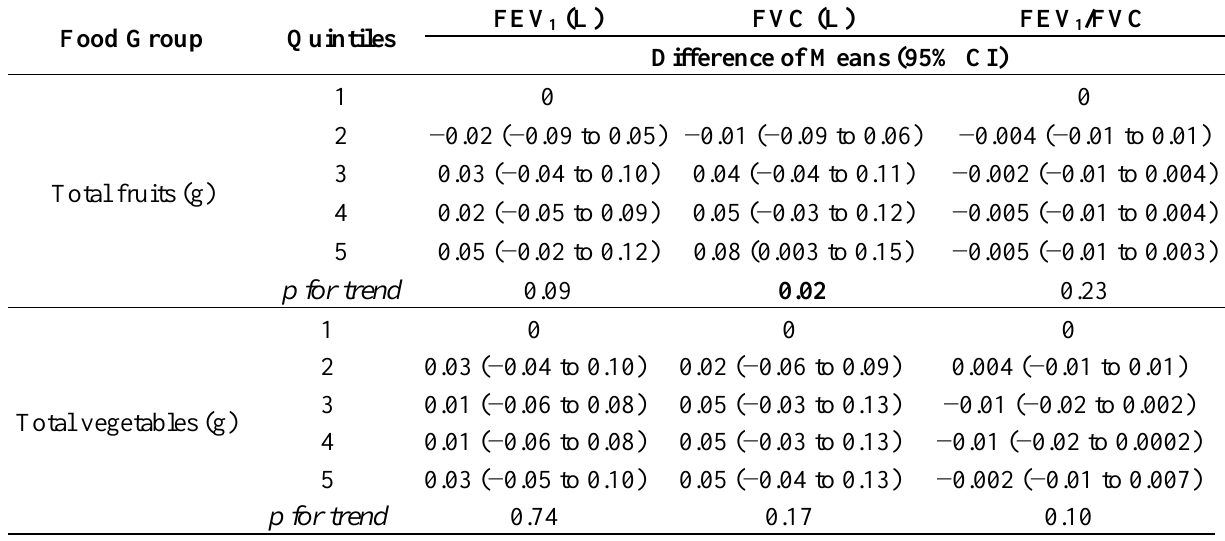
Table 4. The association between ventilatory function and estimated daily intake of fruits and vegetables rich in antioxidants